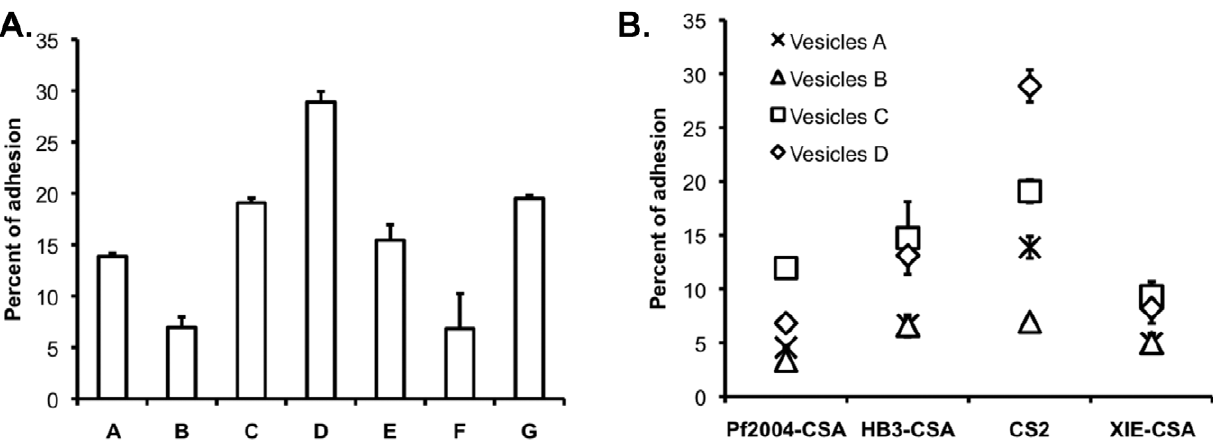
Figure 4. Inter-vesicle and inter-parasite line variations in adhesion. ( a. ) Vesicles were prepared from seven different placentas (A to G) and incubated with IE of the CSA-binding line CS2 at identical vesicle/IE ratios. The percentage of adhesion (percentage of IE with bound vesicles) shows a marked difference in the ability of preparations from different donors to bind to CS2 IE. ( b. ) Four vesicle preparations representative of the range of CS2 adhesion levels observed were selected (A to D) and adhesion levels of four different CSA-binding lines from various geographical origins were measured. A hierarchy exists amongst parasite lines as, regardless of the vesicle preparation used, CS2 shows the highest adhesion levels amongst all parasite lines tested. Such a hierarchy is not found across vesicle preparations as CS2 binds best to vesicles D, whereas other lines adhere better to vesicles C. Results are expressed as mean and standard deviation from experimental triplicates. Data representative of two independent experiments are shown.